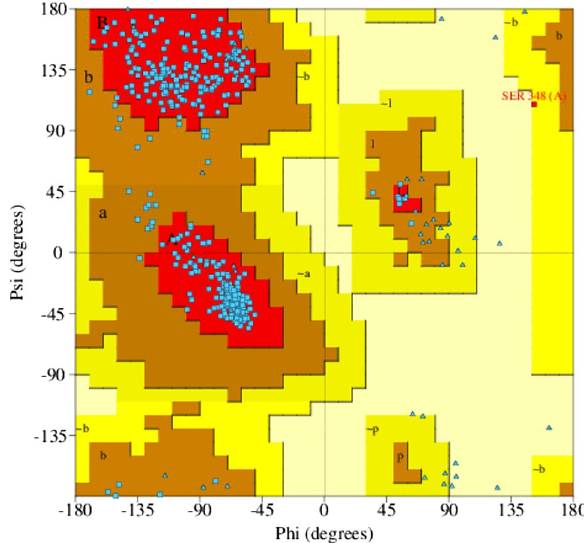
Figure 2. Energy minimized EPSP Ramachandran plot. Details about the coloring of the plot can be interpreted from PDBSum generate server 39 .